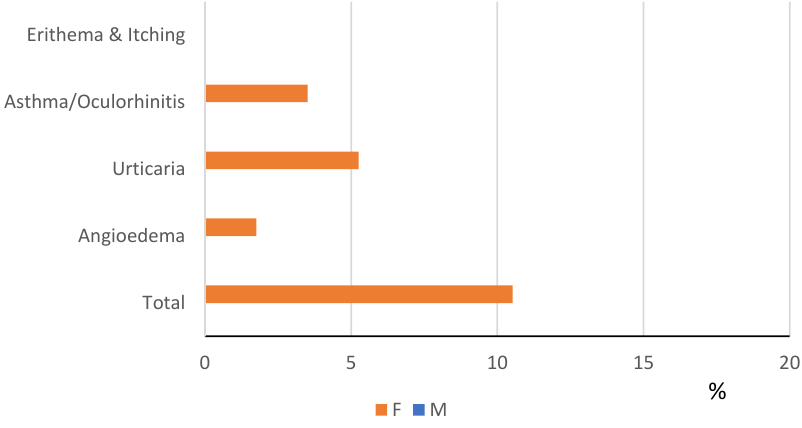
Figure 2. ( a – c ) Distribution of allergic reactions by dose of COVID-19 vaccine administered. M = Males; F =